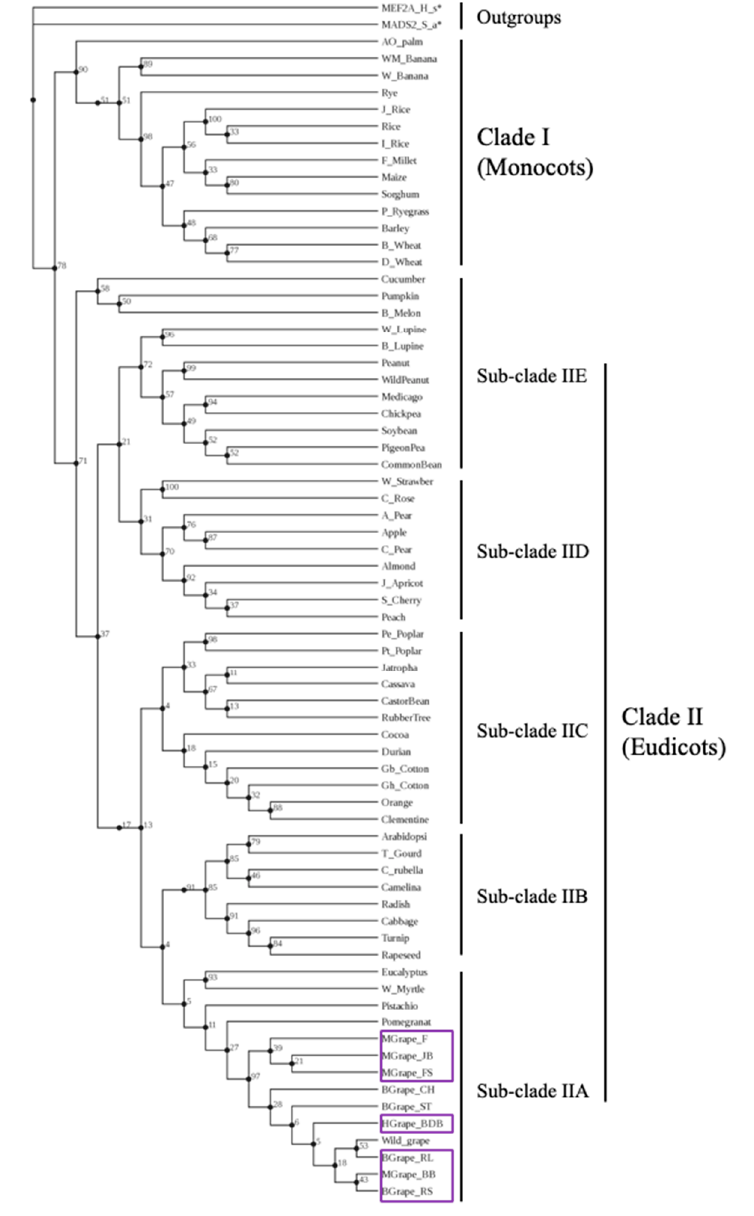
Figure 5. Dendrogram showing the phylogenetic relationship of AGL11 gene of muscadine grape ( VroAGL11 ) with that of other monocot and eudicot plants including bunch, hybrid bunch and wild grape species using MADS-MEF2 transcription factor of fungus Scedosporium apiospermum (XP_016645827.1, MADS-MEF2_S.a*) and myocyte-specific enhancer factor 2A of Homo sapiens (XP_016877691.1, MEF2A_H.s*) as outgroups. The amino acid sequences of AGL11 gene of muscadine (BB = Black Beauty, JB = Jane Bell, F = Fry, and FS = Fry Seedless) and hybrid bunch grape (BDB = Blanc du Bois) and bunch (RL = Riesling, RS-Reliance Seedless) sequenced in this study are shown in violet box. The phylogenetic tree was constructed based on amino acid sequences of AGL11 or AGL11-like protein by the PhyML 3.0 [33] using maximum likelihood method with LG (Le and Gascuel) model [34] and bootstrap analysis. The accession numbers of the amino acid sequences of AGL11 or AGL11-like protein of monocots and eudicots are provided in Table